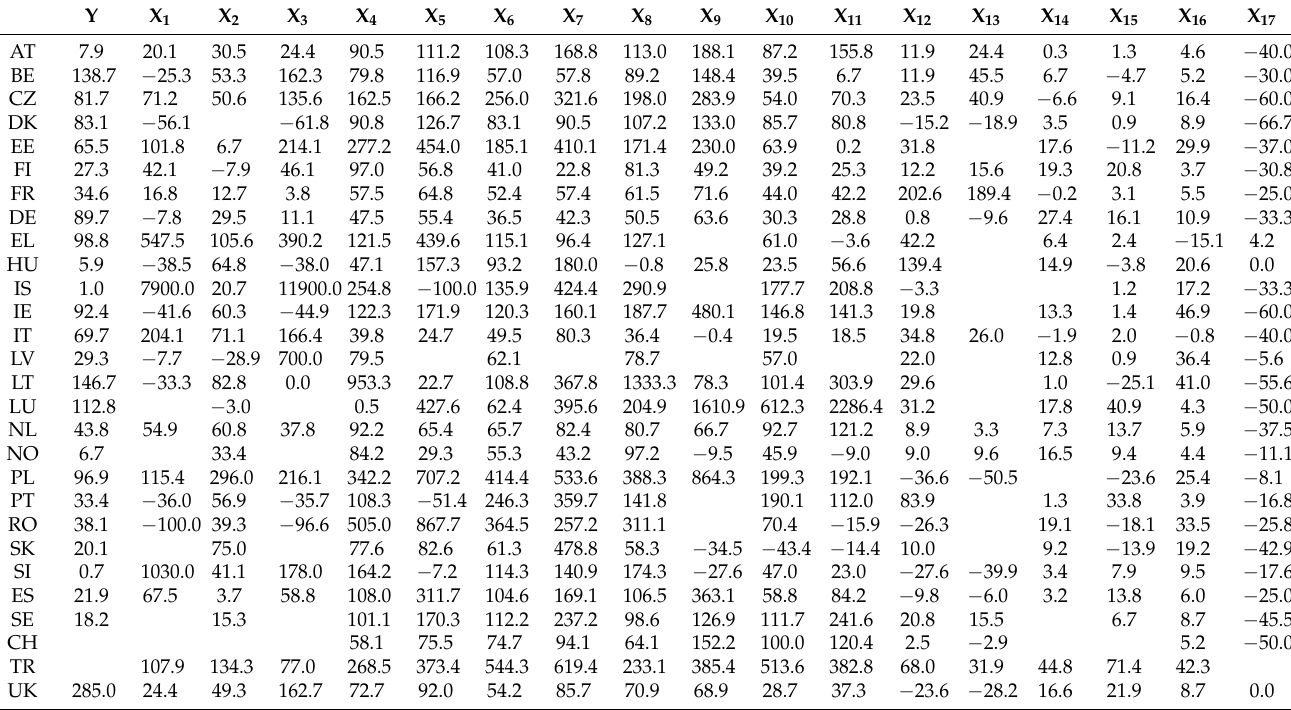
Table 4. Normalized indicators’ change